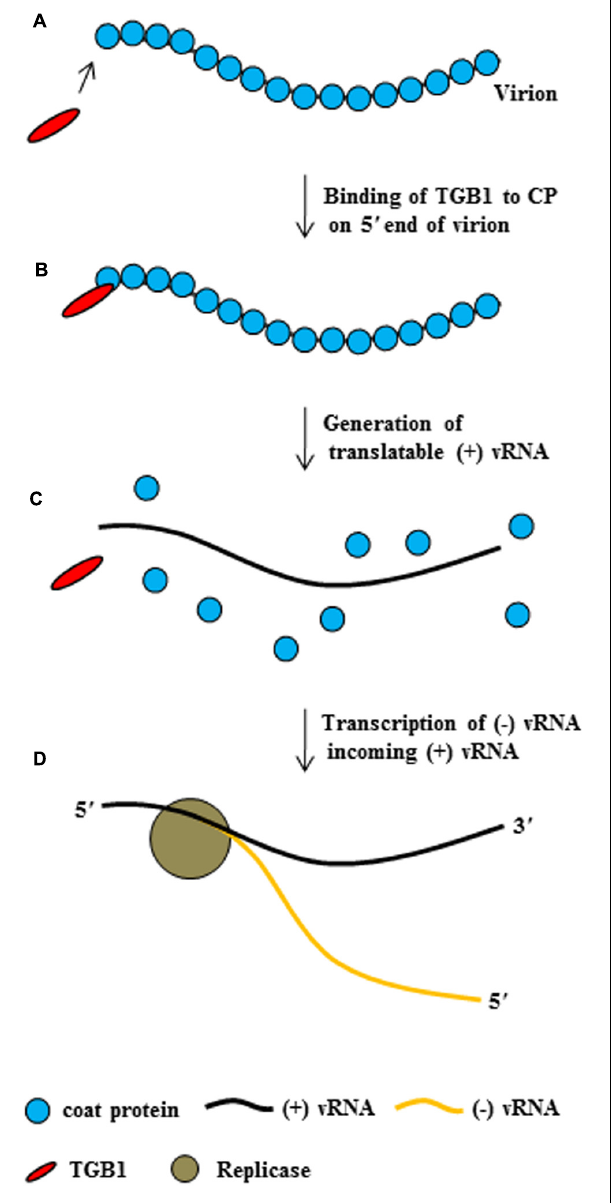
FIGURE 4 |The conversion of potexvirus virions into translatable vRNA. PVXTGB1 protein binds to polar CP subunits located at the end of PVX virion (A,B) .Then, binding ofTGB1 protein causes the CP to separate from the PVX virion (C) early in infection after movement of virion into uninfected adjacent cells, such that the virion become translatable. Replicase then replicates ( − ) vRNA from the translatable form of PVX ( + ) vRNA (D) , replicase transcribed ( − ) vRNA from ( + ) vRNA, and finally (not shown), ribosomes bind to the ( + ) vRNA.